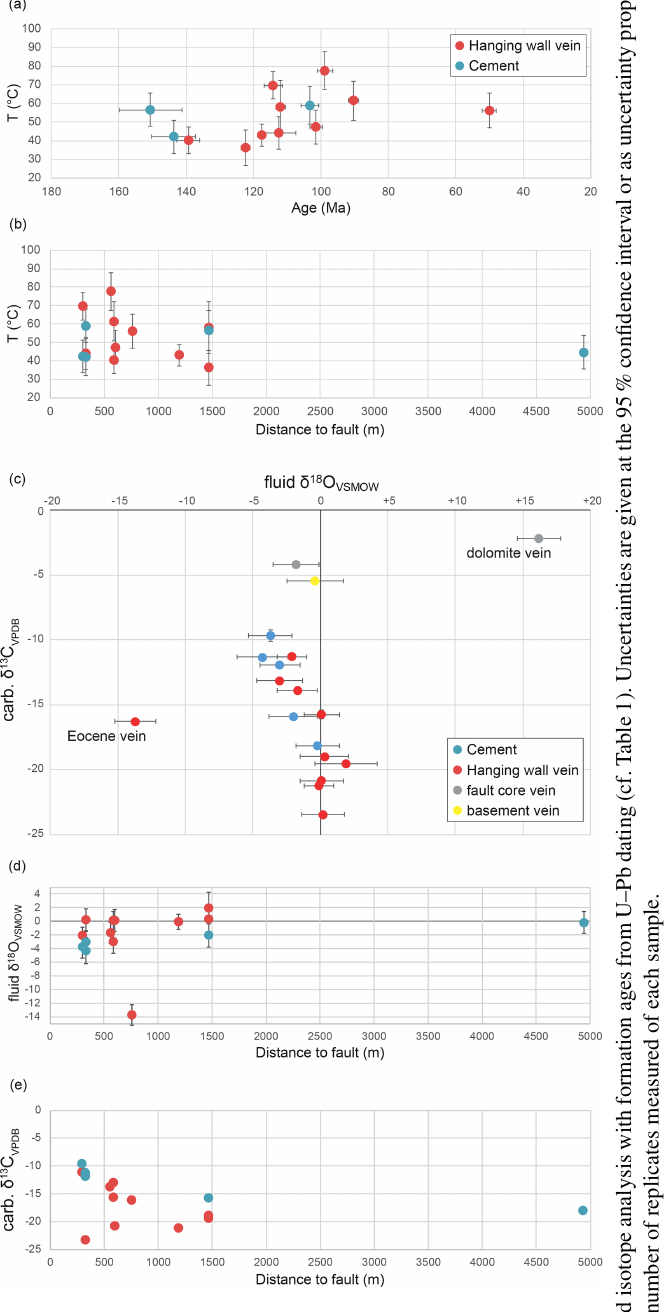
Figure 9. (a) Calcite formation temperatures obtained from clumped isotope analysis against formation ages obtained from U–Pb dating; (b) calcite formation temperatures against dis- tance to Dombjerg Fault; (c) fluid δ 18 O VSMOW against carbonate δ 13 C VPDB ; (d) fluid δ 18 O VSMOW against distance to fault; (e) car- bonate δ 13 C VPDB against distance to fault (error bars represent the 95% confidence